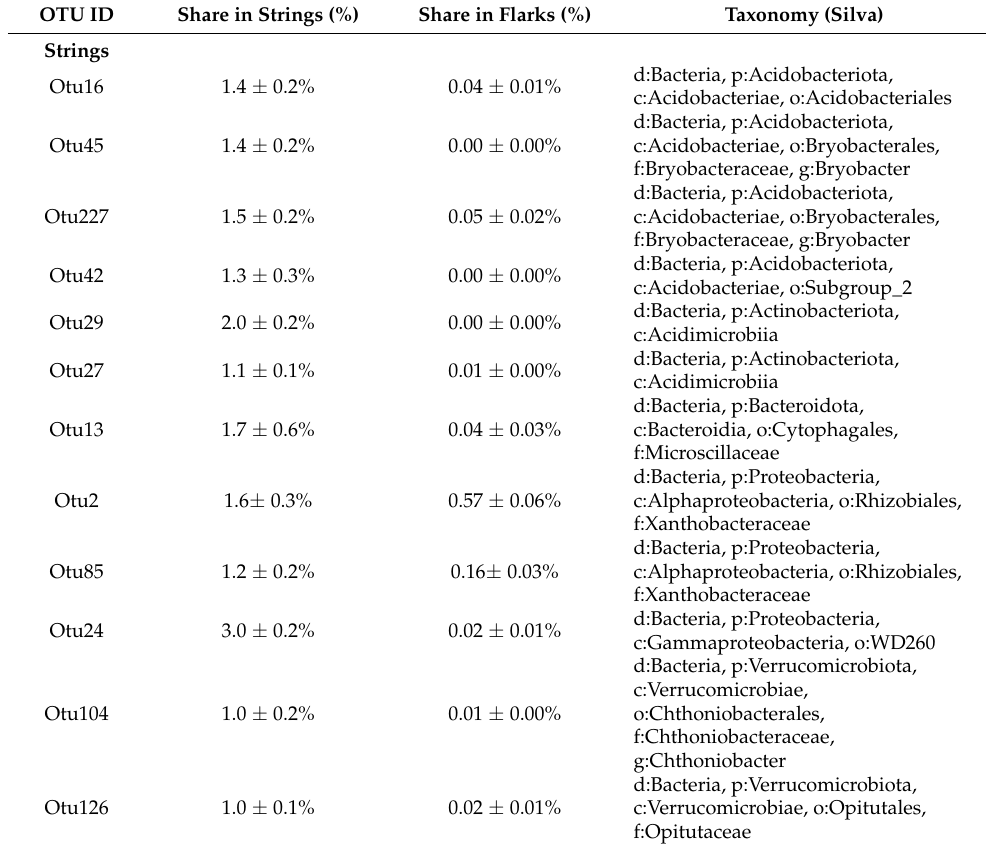
Table 3. Most abundant OTUs in microbial communities of string and flark